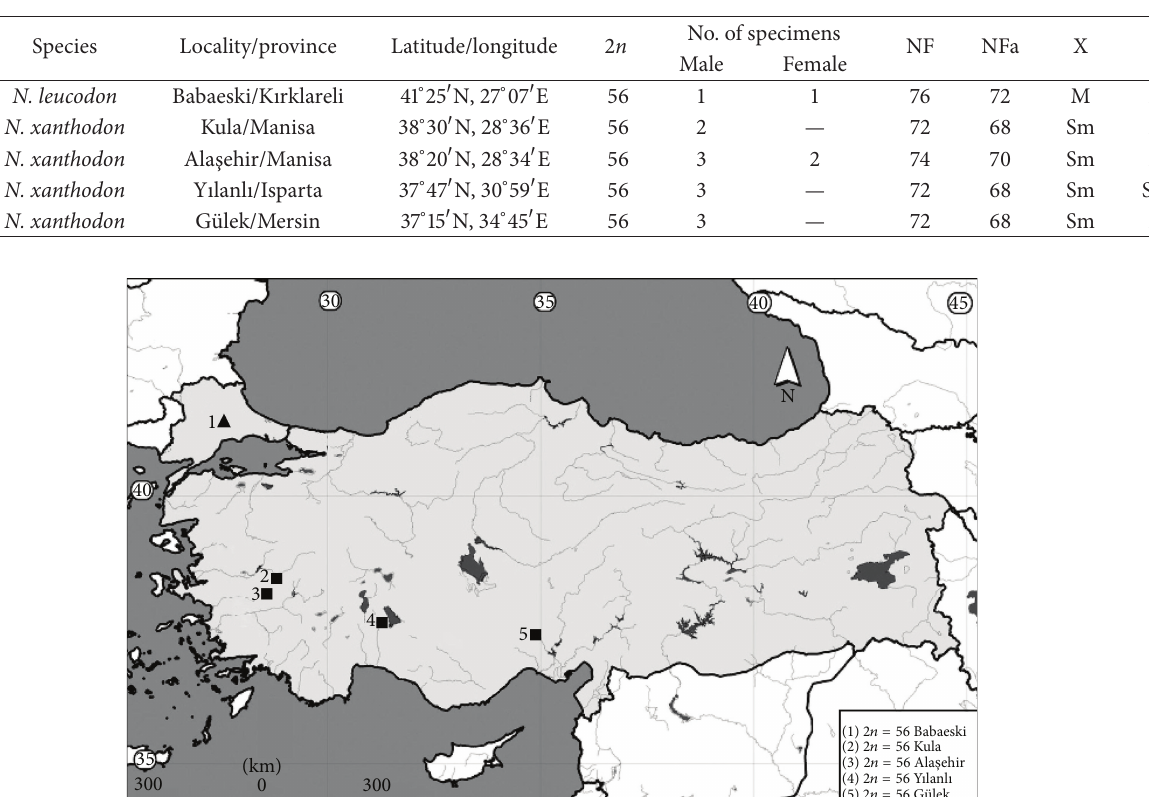
Table 1: Studied localities of Nannospalax leucodon and N. xanthodon in Turkey. The numbering of the sampling sites corresponds to data in Figure 1.